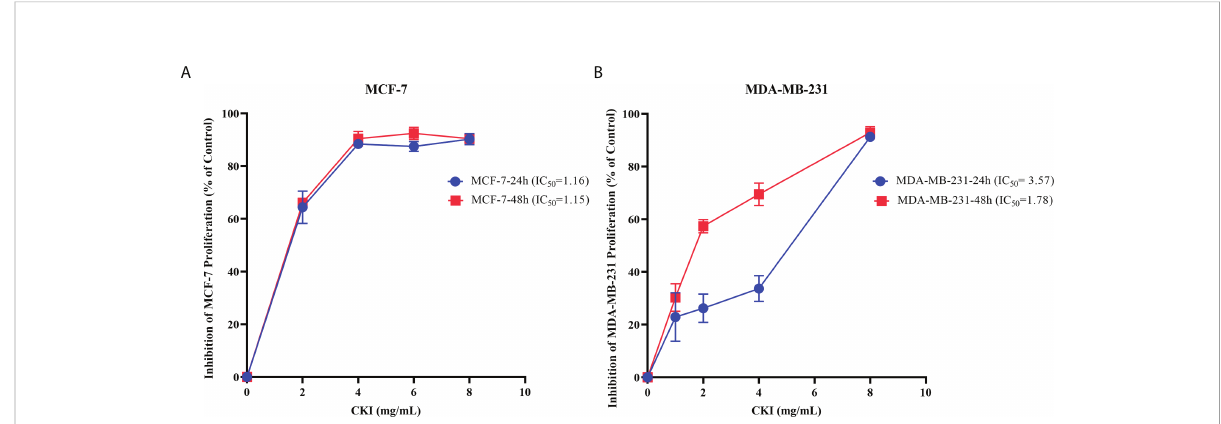
FIGURE 8 Inhibition of MCF-7 and MDA-MB-231 proliferation. Notes: (A) The inhibition of MCF-7 proliferation (% of Control). (B) The inhibition of MDA- MB-231 proliferation (% of Control). n=3. Data are presented as means ±